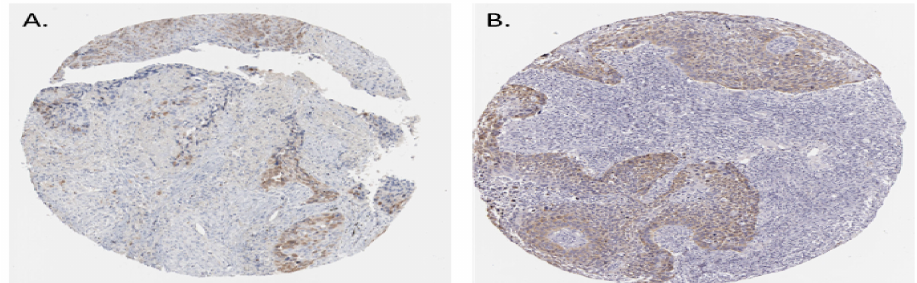
Figure 10. Histological images of CDK1 and HSP90AA1 in squamous cell carcinoma. ( A ) The sample is from Male, age 54 (HPA003387), Lung (T-28000) Squamous cell carcinoma, NOS (M-80703), Patient id: 1727 and for HSP90AA1 ( B ) The sample is from Male, age 68 (CAB002058), Lung (T-28000) Squamous cell carcinoma, NOS (M-80703), Patient id: